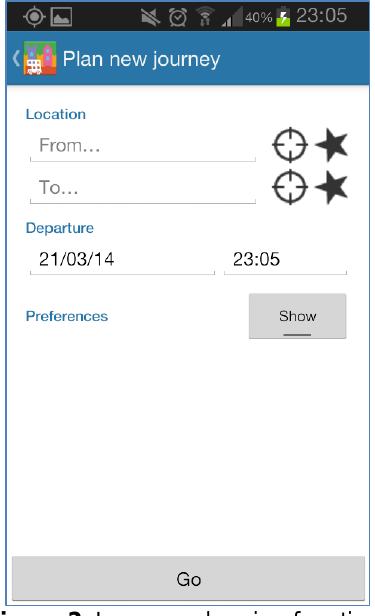
Figure 2. Journey planning functionality